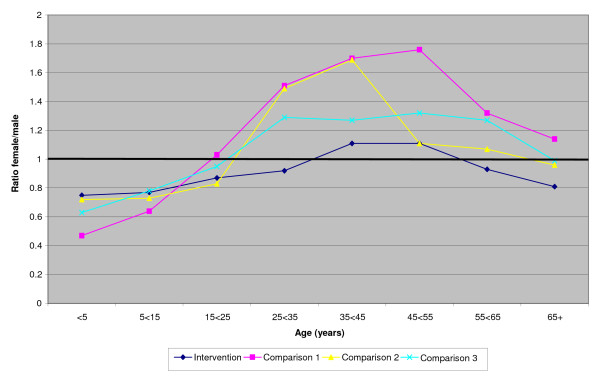
Female/male ratios by age group for registrations during the intervention period in each Township: gender determined disease and THC inpatients omitted (ratios corrected for population ratios - see text)